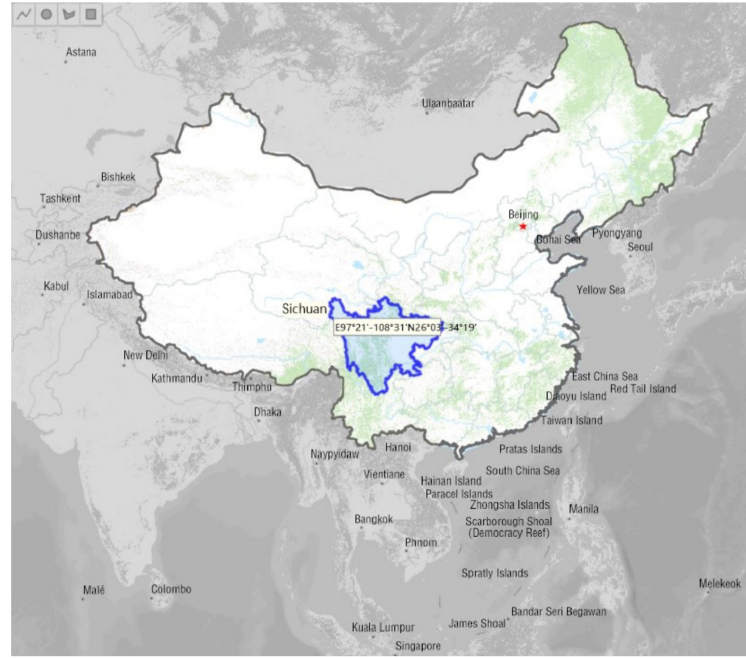
Figure 2. Location of Sichuan